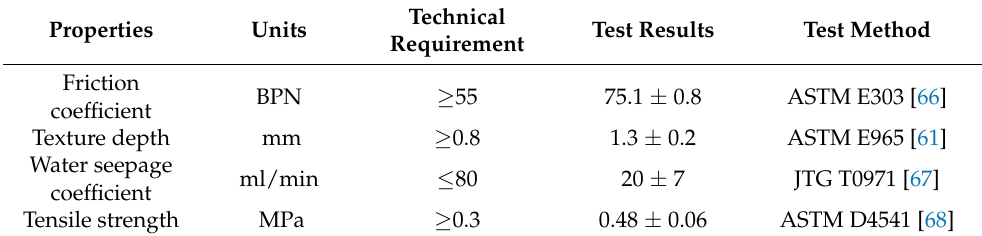
Table 15. HCUP-8 quality acceptance requirements and test results.